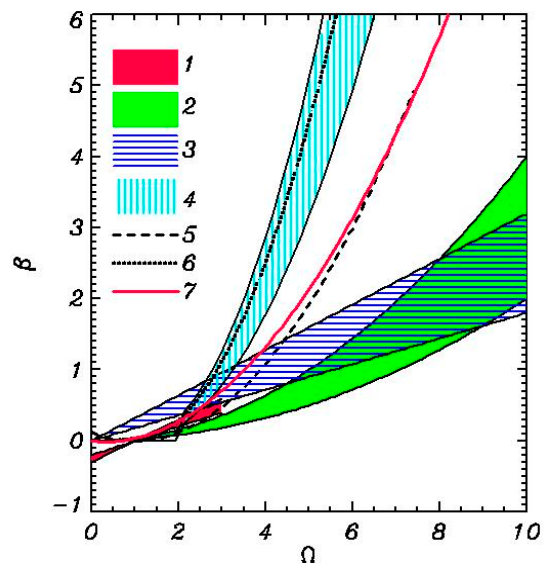
β Ω Figure 1. Shape of β as a function of nondimensional frequency Ω . The filled areas characterize Figure 1. Shape of as a function of nondimensional frequency . The filled areas characterize uncertainty of approximation. 1—Snyder [29] (red color in the interval (0–2.5); 2—Plant [36]; uncertainty of approximation. 1—Snyder [29] (red color in the interval (0-2.5); 2—Plant [36]; 3— 3—Hasselmann and Bösenberg [31]; 4—Donelan [32,33]; 5—Hsiao [30]; 6—Donelan [37];